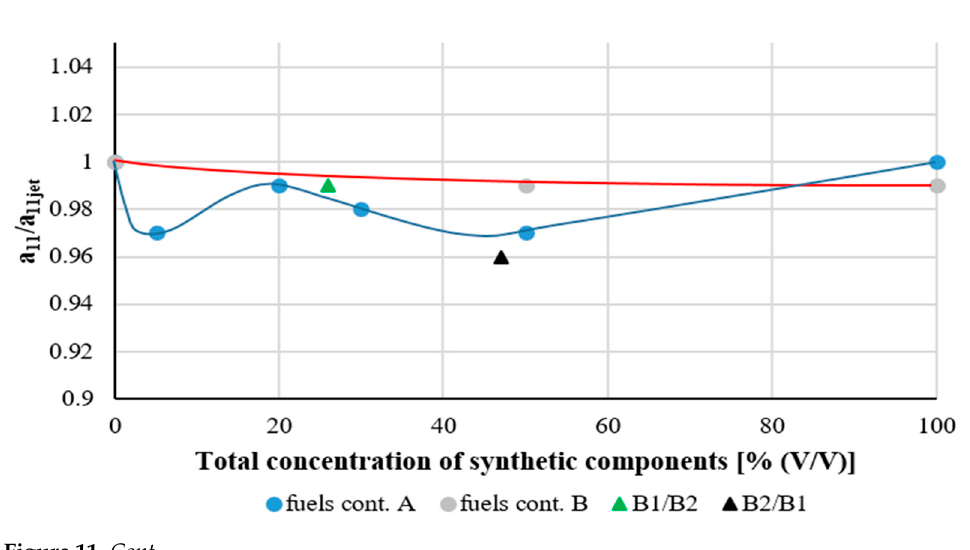
Figure 10. Dependences a/a Jet and n/n Jet on the total concentration of synthetic components A and B.